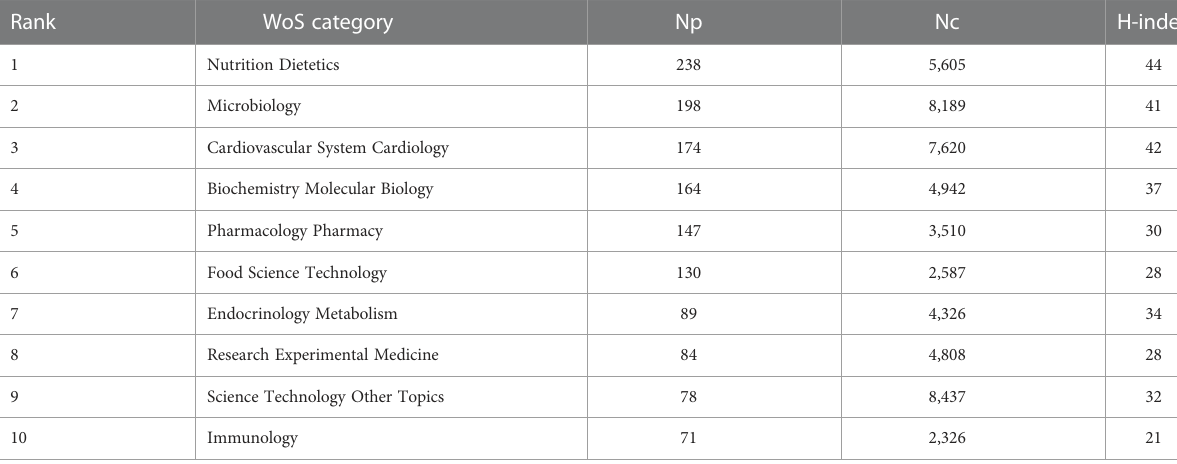
TABLE 4 The top 10 subject categories in the studies of in this fi eld.